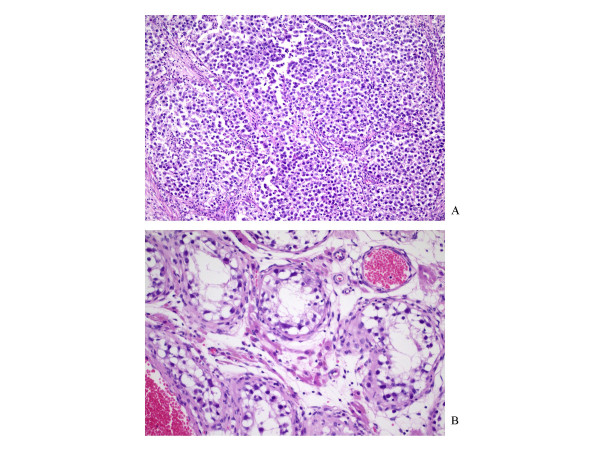
Photomicrograph of classic seminoma of the testis. A: H&E section shows compact nests of large tumor cells are separated by thin fibrous septa infiltrated by lymphocytes. B: Intratubular germ cell neoplasia in H&E section (×100). A row of atypical germ cells with clear cytoplasm is seen against a thickened basement membrane. No spermatogenesis is occurring in this tubule (×200).